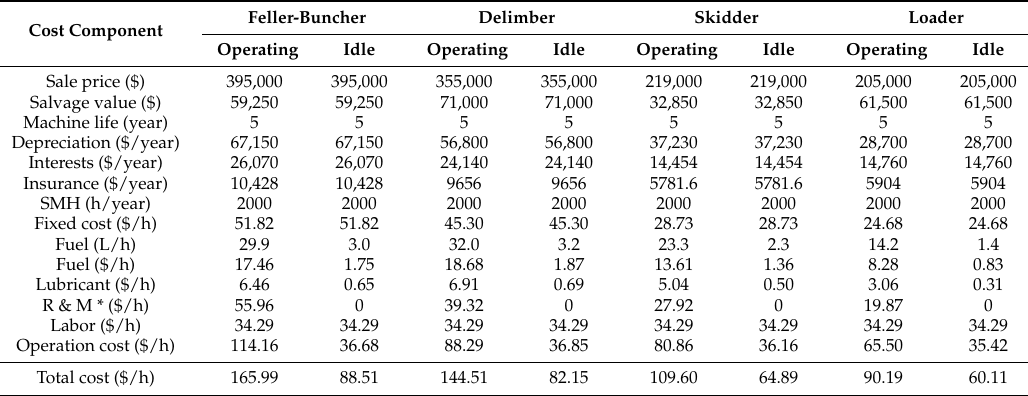
Table 2. Estimated hourly costs of each machine in the